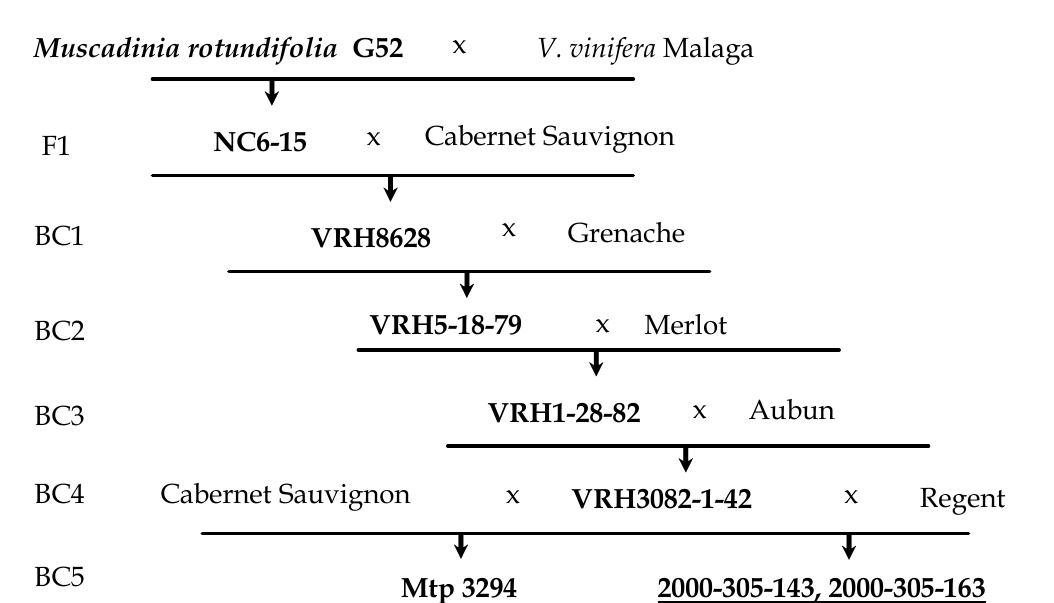
Figure 1. Scheme of backcrosses in order to complete the introgression of genes for resistance to powdery and downy mildew from M. rotundifolia to the genetic background of V. vinifera . Resistant BC progeny are marked in bold.